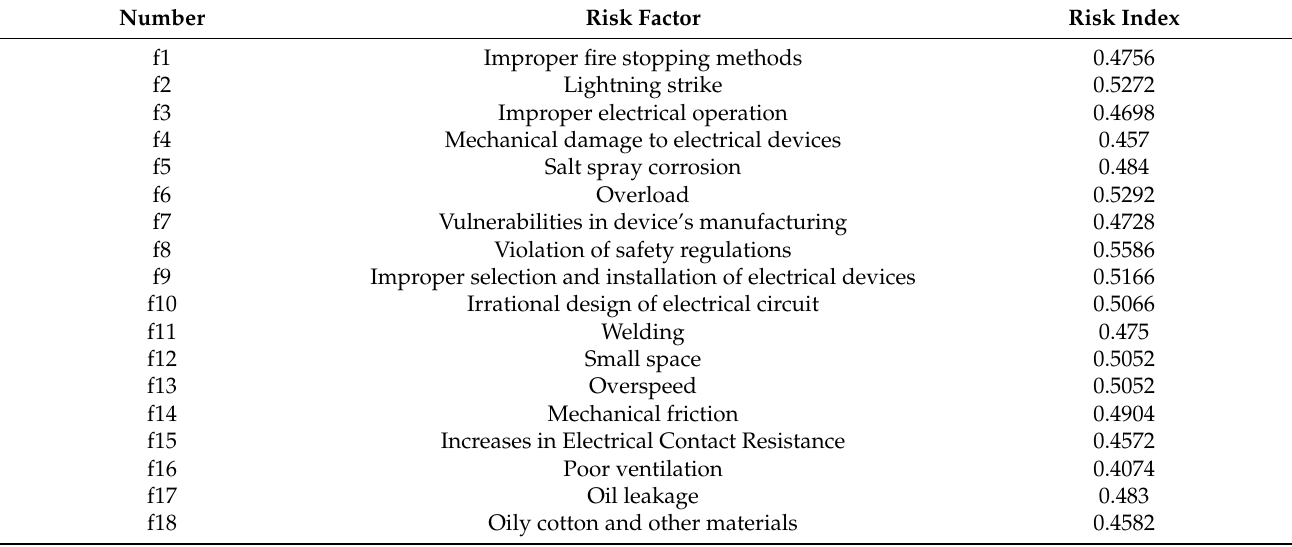
Table 3. Fire risk factors of offshore wind